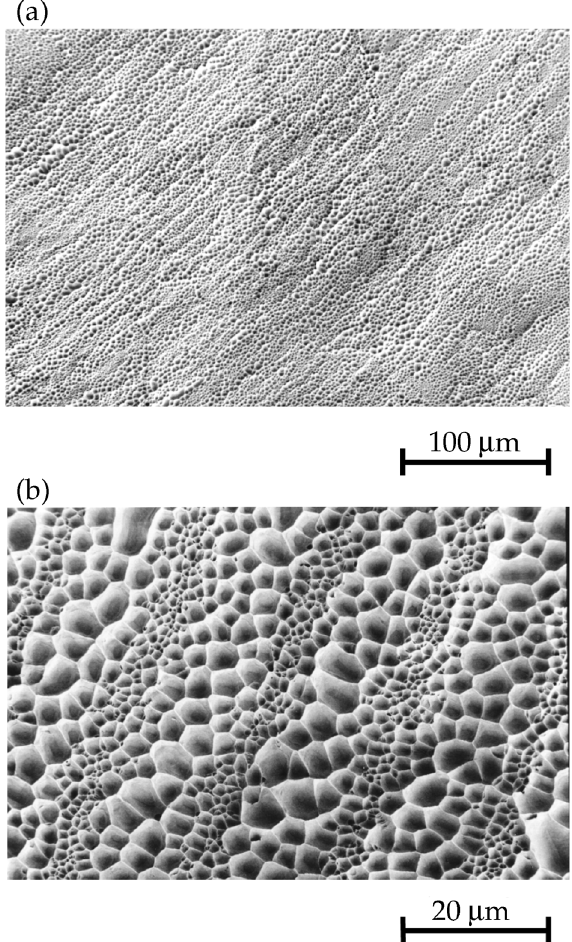
FIG. 15. SEM image of the fracture surface from 800 ± C dif- fusion bonded parts that had been diamond turned. (a) The dimple pattern is radial, which corresponds to the machining grooves left during the turning operation. (b) The dimple pat- tern at higher magnification shows alternating bands of small and large